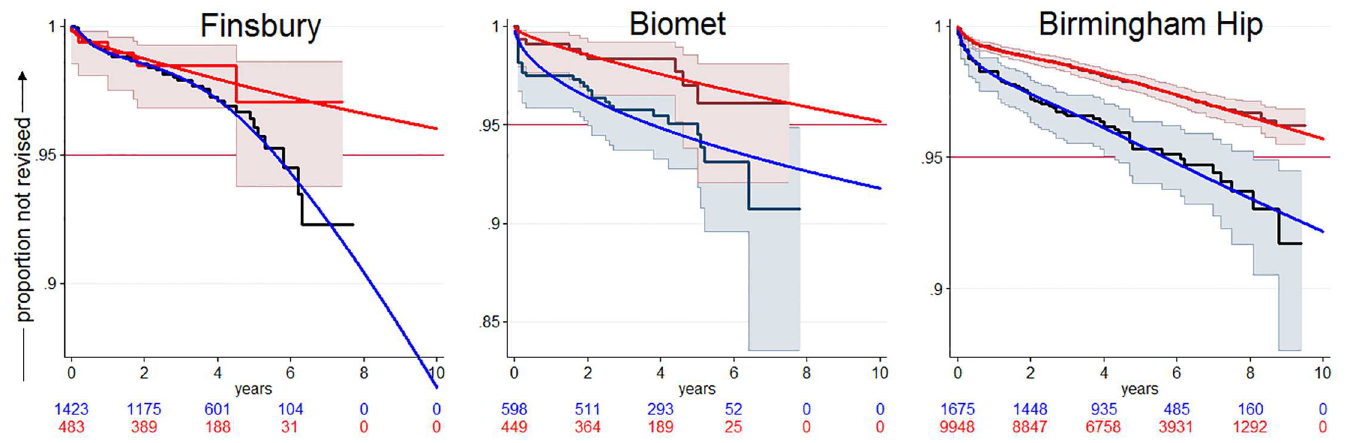
Fig 3. Estimated ten-year revision rates dichotomized by head size-patient combinations satisfying and not satisfying the ten year benchmark of 5%. The data are for male patients of ASA 1 plus ASA 2 grade receivingRS devices from different manufacturers (the subgroups within the NICE benchmarkfor revision were as follows: Finsbury (mean age 51.3 years): head sizes 48 or less and head size 50 if patient age was less than 50 years at intervention; Biomet (mean age 50.4 years): head size 50 if age less than 55 years, head sizes 52, and 54 if age less than 60 years; Birmingham Hip (mean age 55.5 years) head sizes 50 or greater and head size 48 if age less than 45 years). Note the more mature data for Birmingham Hip. For clarity the 95% CI of the Kaplan Meier plot for the Finsbury below-benchmark subgroup has been omitted.